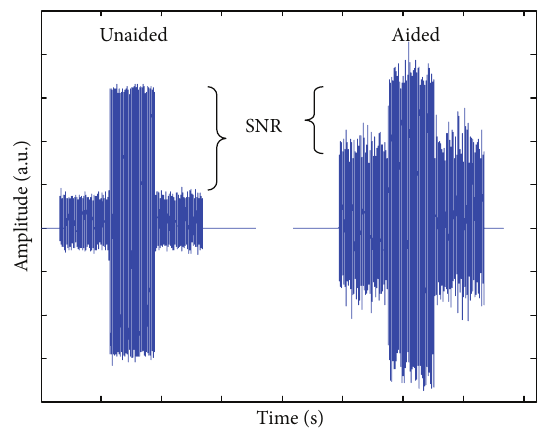
Figure 2: Time waveforms of in-the-canal acoustic recordings for one individual. The unaided (left) and aided (right) conditions are shown together. Signal output as measured at the 1000Hz centered 1/3 octave band was approximately equivalent at 73 and 74 dB SPL for the unaided and aided conditions. However, noise levels in the same 1/3 octave band were approximately 26 and 54 dB SPL, demonstrating the significant change in